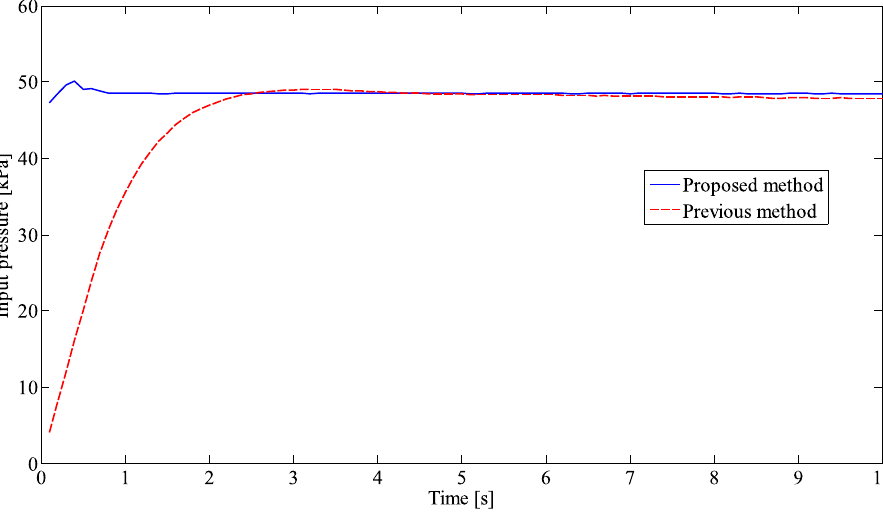
Figure 13. The input pressure of the proposed method compared with previous